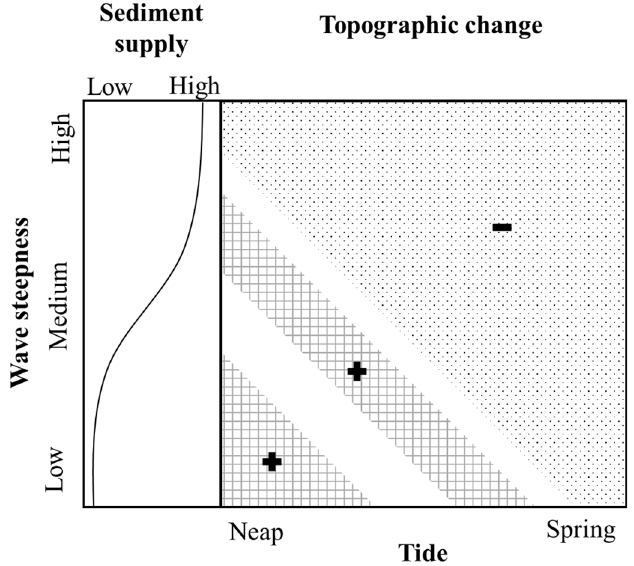
Figure 10. Conceptual summary of the combined effects of waves through wave steepness, tide, and sediment supply on the intertidal beach volume, with checkered, white, and spotted indicating accretion, stability, and erosion, respectively.